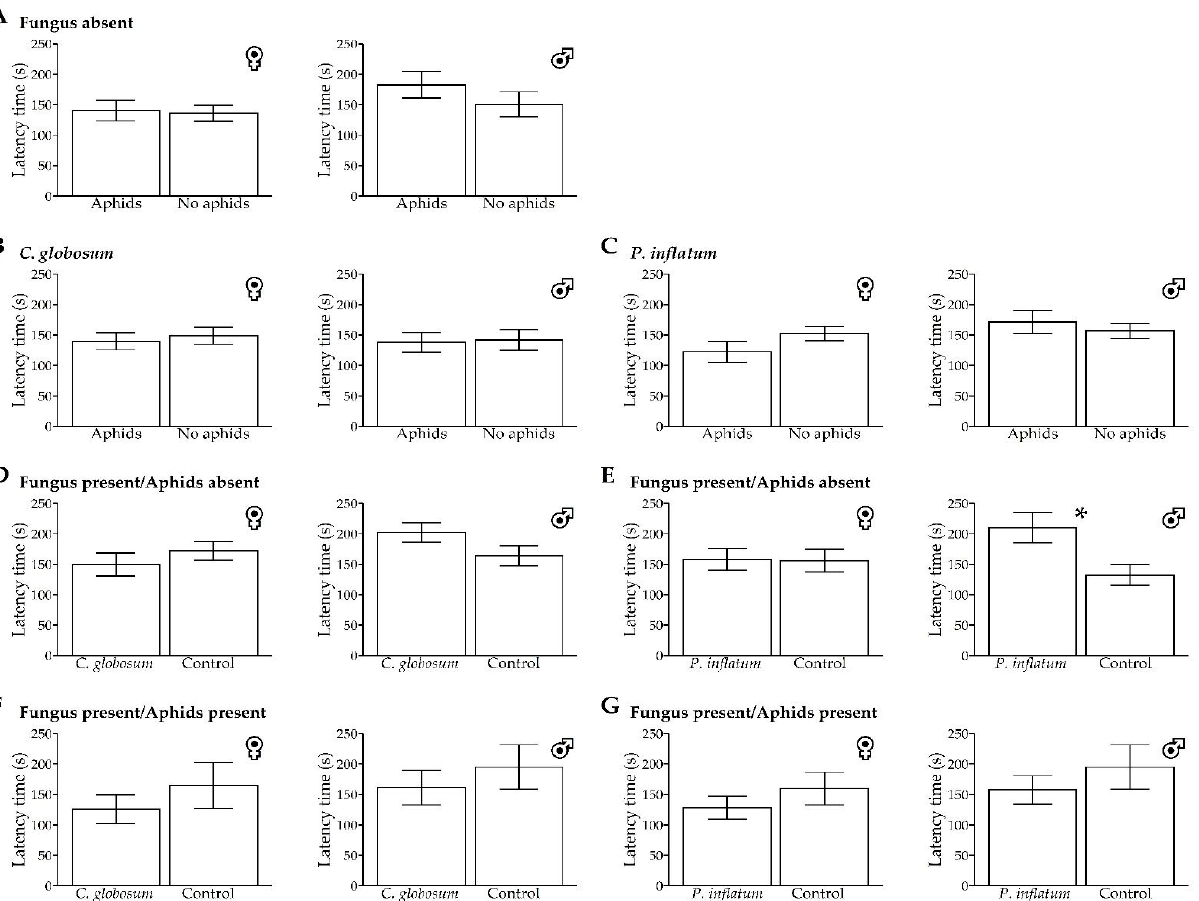
Figure 3. Means ( ± SE) of Hippodamia convergens female and male latency (seconds) to make a choice between olfactory stimuli emitted from untreated control and fungal-treated ( Chaetomium globosum and Phialemonium inflatum ) cotton plants in a dual-choice Y-tube olfactometer. ( A – C ) Untreated plants, C. globosum, and P. inflatum treated plants with aphids vs. no aphids, respectively. ( D , E ) Fungal-treated plants vs. untreated plants, both without aphids. ( F , G ) Fungal-treated plants vs. untreated plants, both with aphids. Each individual had 300 s (five minutes) to make a choice from a total of 600 s, and the beetles that did not respond were not included in the analysis. * p < 0.05 (Welch’s two-sample t -test).